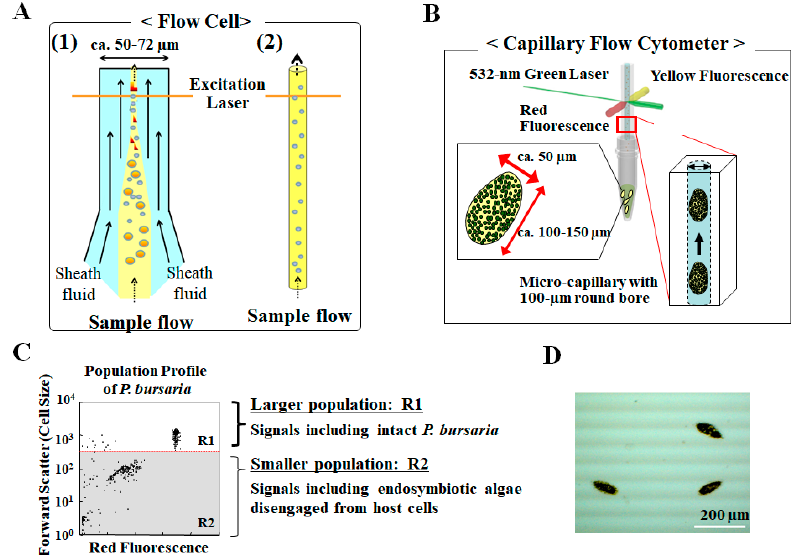
Figure 4. Analytical overview of P. bursaria using capillary FCM. ( A ) Diagrammatic view of a flow cell to pick up single cells one-by-one for flow cytometers. Panels (1) and (2) respectively present a conventional flow cytometer with hydrodynamic focusing and a capillary flow cytometer. ( B ) Overview of the system using a capillary FCM. Cells that had gotten through a rectangular capillary are measured using a capillary FCM. This system can detect forward scatter signals, chlorophyll fluorescence in the red fluorescence channel (680/30 nm BP filter), and fluorescence in the yellow channel (576/28 nm BP filter) simultaneously. ( C ) Example of FCM measurements of P. bursaria fixed with 5% ( v / v ) formalin using capillary FCM: the scatter plot shows the detection of intact P. bursaria host cells (R1) and endosymbiotic algae (R2) disengaged from P. bursaria . ( D ) This microscopic image shows samples collected from the waste bottle of the capillary flow cytometer. Panels ( B – D ) were referred from the literature [34], but were modified.